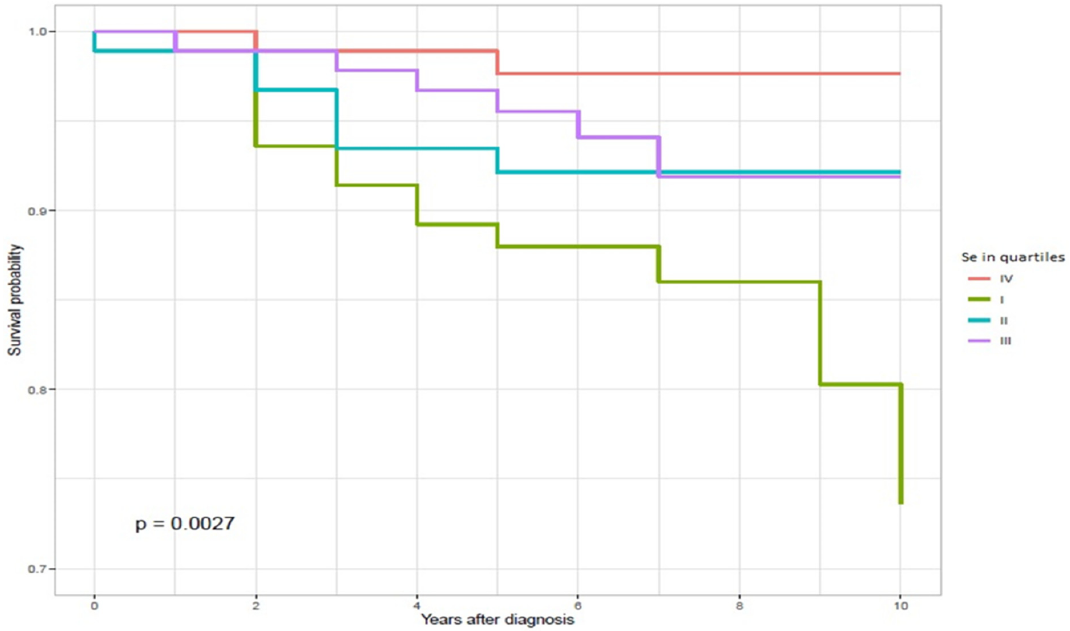
Figure 1. Ten-year survival by serum selenium levels (quartiles) in MM patients. No significant difference in the selenium concentration was observed in relation to sex ( p = 0.7362).